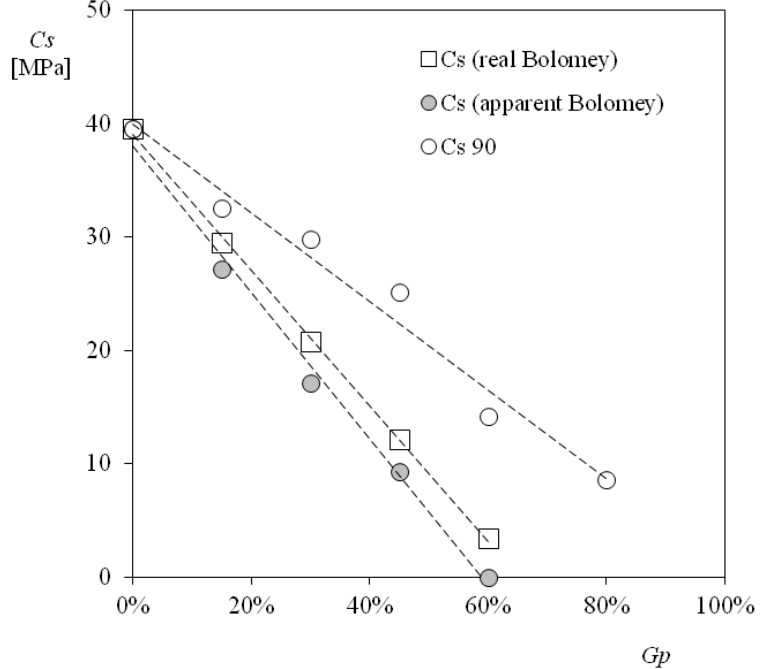
Figure 8. Compressive strength, Cs , 90 days after setting, with regard to the amount of glass powder